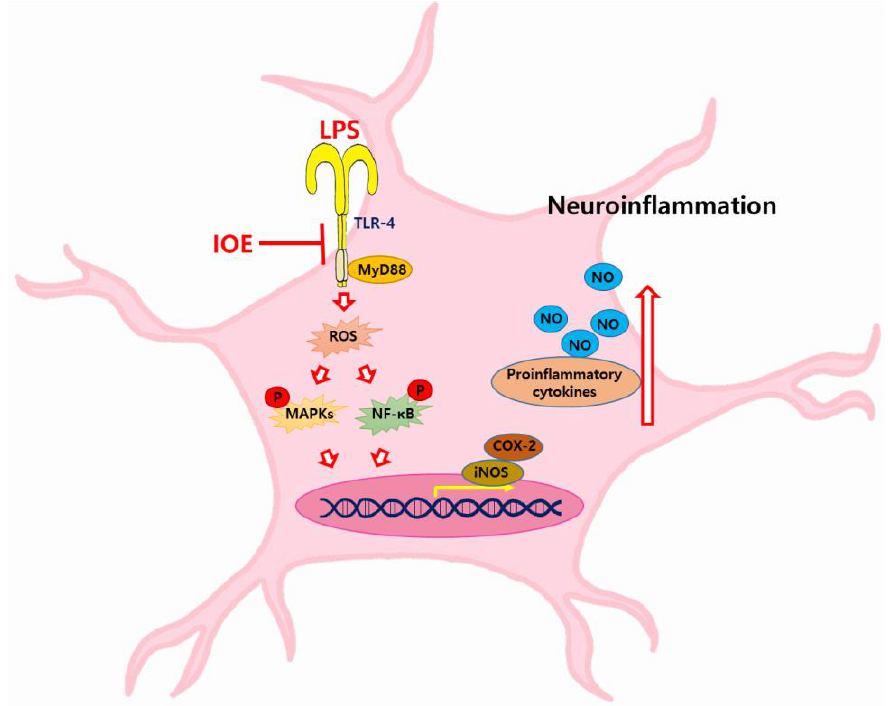
Figure 11. Schematic diagram of the anti-neuroinflammatory effects of IOE. TLR-4/MyD88 mediated inflammatory signaling in brain tissue has been considered as a major pathway to transmit the neuroinflammatory signals. LPS can activate the TLR-4/MyD88 in brain, and it make ROS over- production, lead to MAPKs and NF κ B activation. These TLR-4 mediated inflammatory responses stimulate the expression of inflammation mediators such as iNOS, COX-2, proinflammatory cytokines and NO. These continuous responses finally cause neuroinflammation in the brain. Our results suggest that oral administration of IOE can ameliorate the LPS-induced neuroinflammation through attenuating the TLR/MyD88 activation and its downstream inflammatory